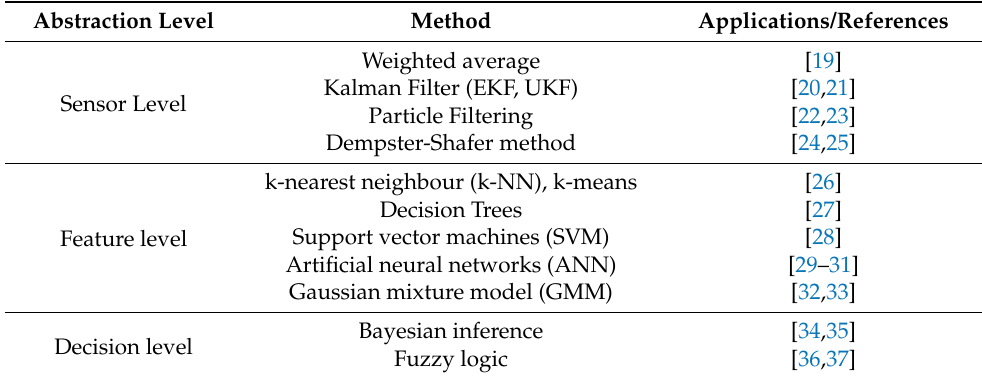
Table 1. Overview of data fusion algorithms at sensor, feature and decision